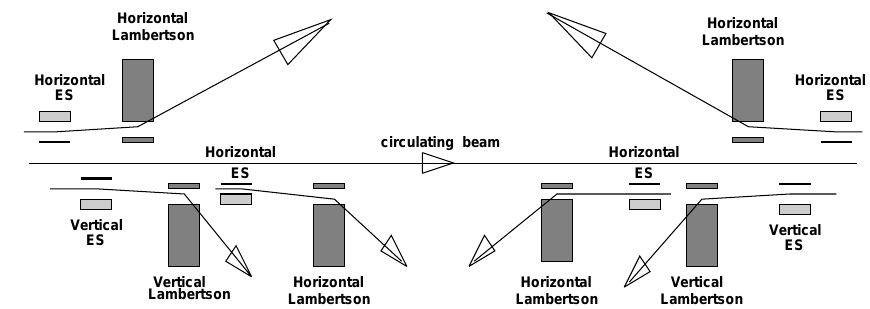
FIG. 51. Schematic view of a m 1 m 2 collider beam halo extraction.